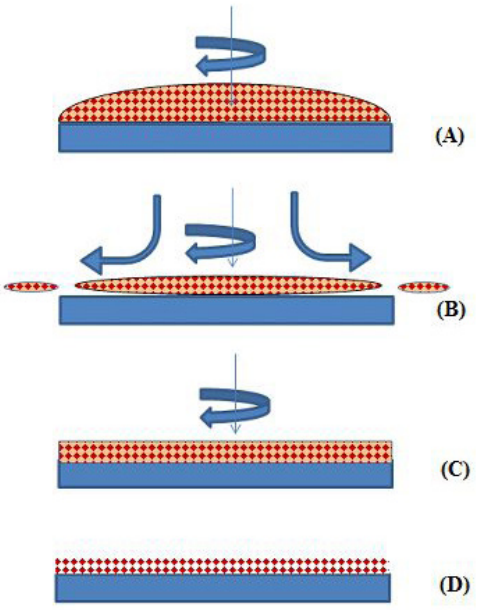
Figure 1. The mechanical process of spin coating technique.